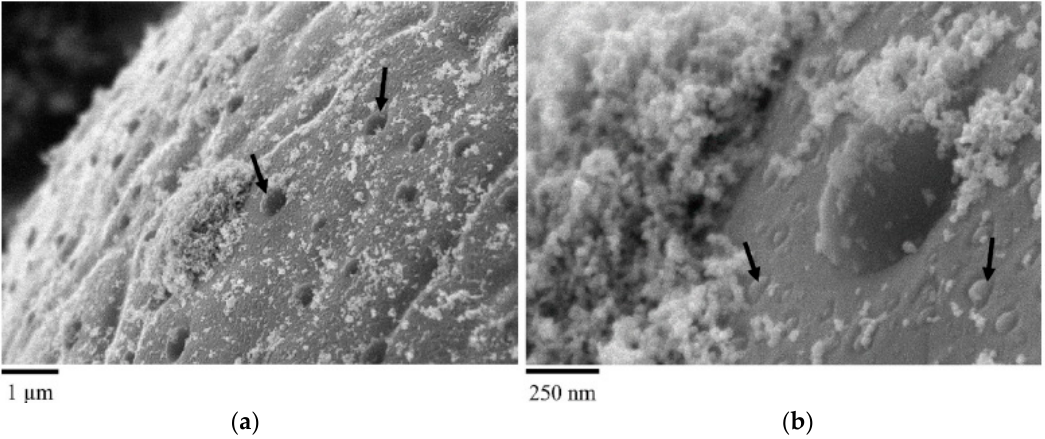
Figure 8. Scanning electron microscopy (SEM) micrographs showing ( a ) spatter with oxide islands, and ( b ) higher magnification of the spatter surface. Oxide islands on 304L stainless steel with dimensions ranging from 1 µm to 100 nm (approximately) are depicted with arrows in both images. Adapted from Reference [101] with permission from Elsevier.